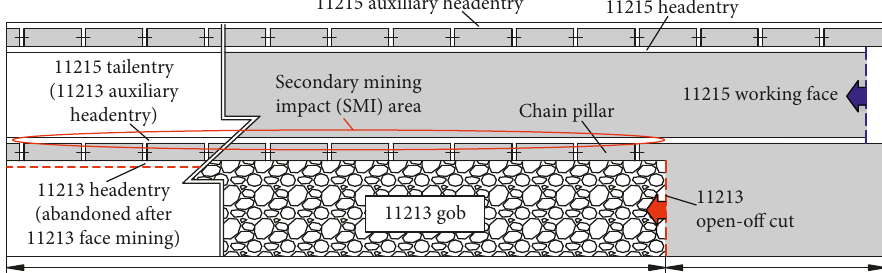
Figure 3: Layout of the working